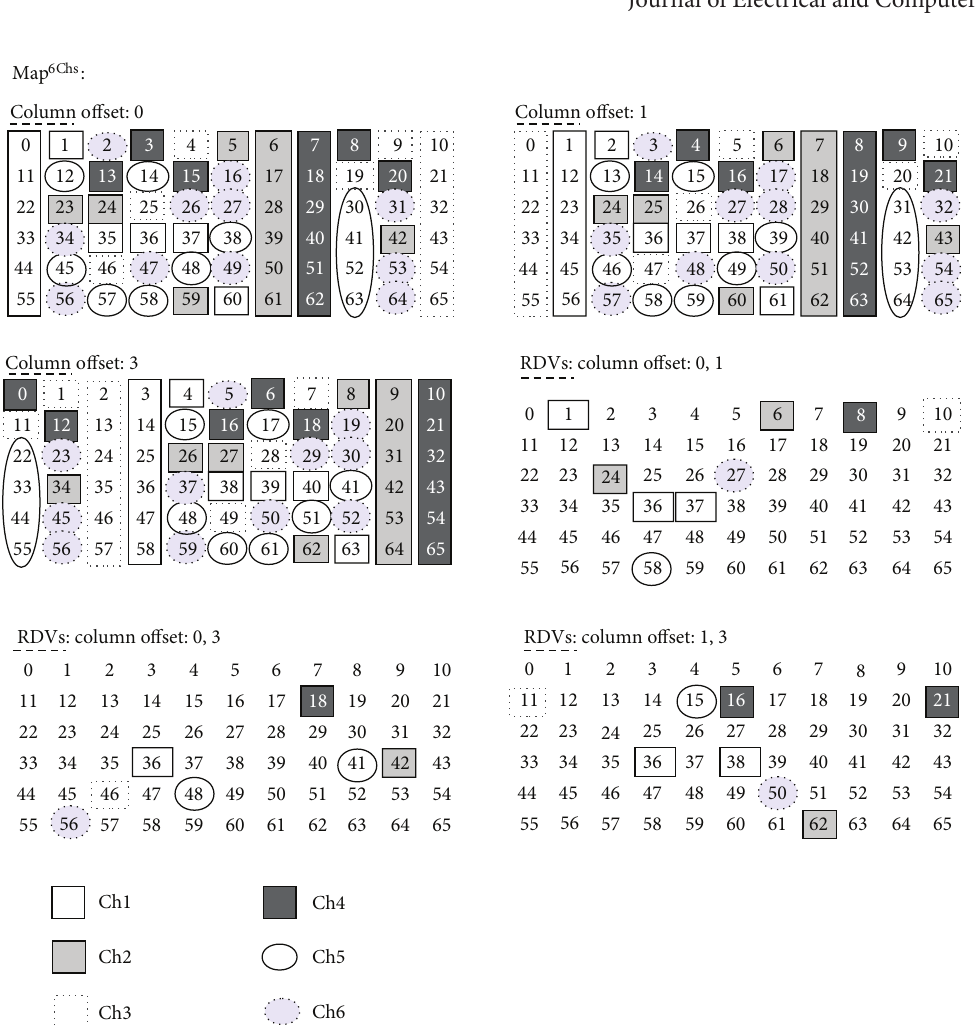
8 available channels, using channel maps from Figure 5. Table 1: MtQS-DSrdv in SCHv, so is slot offsets ; ( 𝑟, 𝑛 ) = {(2,6) ,